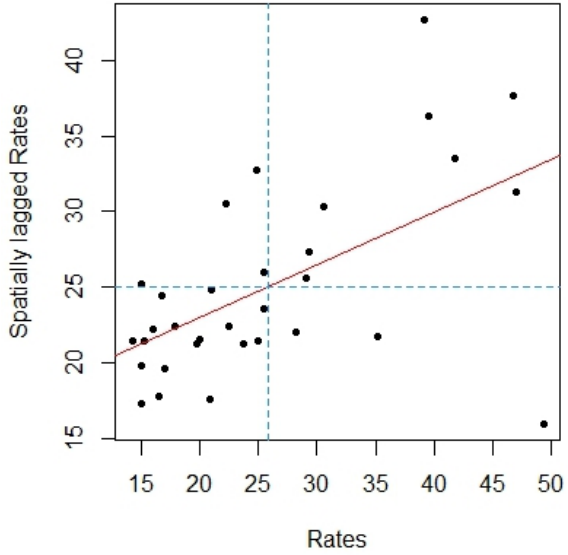
Figure 2. Moran’s scatterplot for the variable